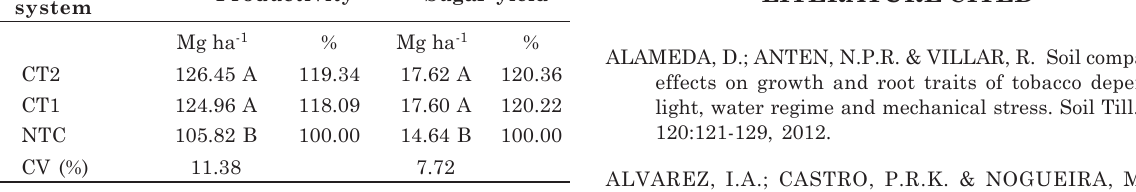
Means followed by the same capital letter in the column did not differ statistically